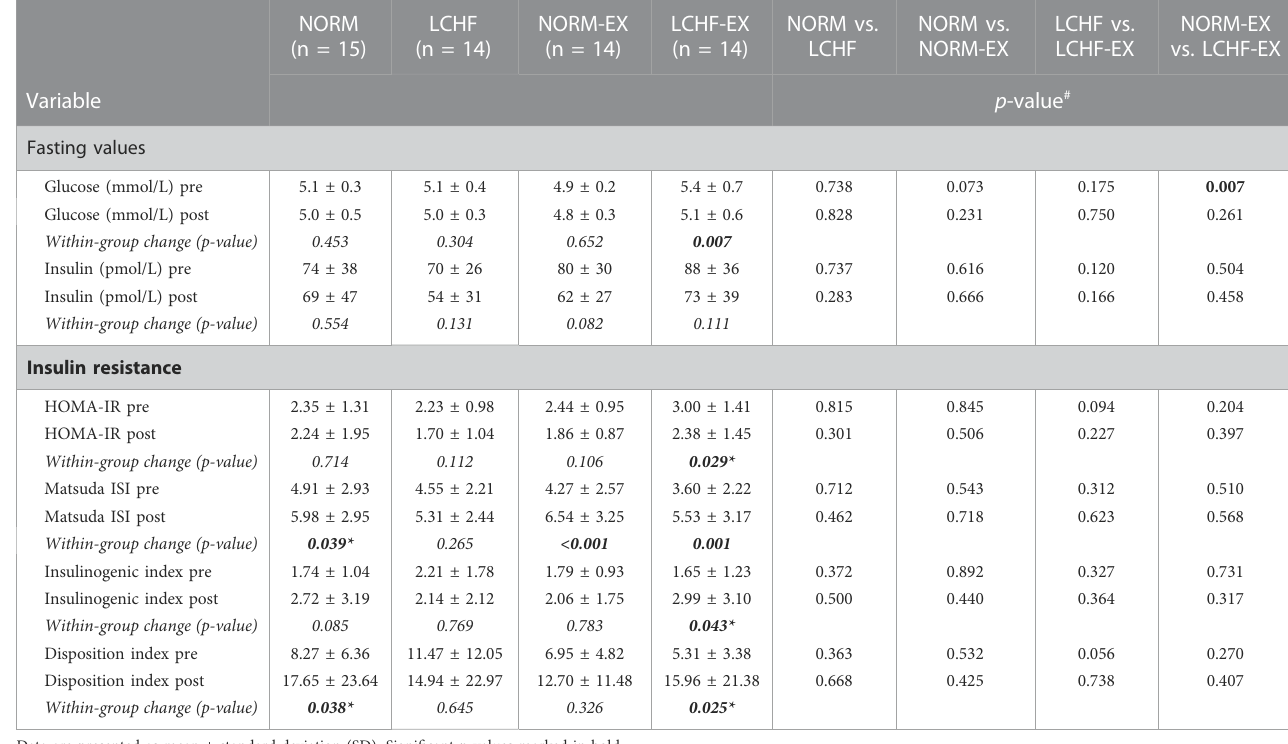
TABLE 3 Primary outcome: Fasting values for glucose and insulin, and markers of insulin resistance at baseline and after the 10-week